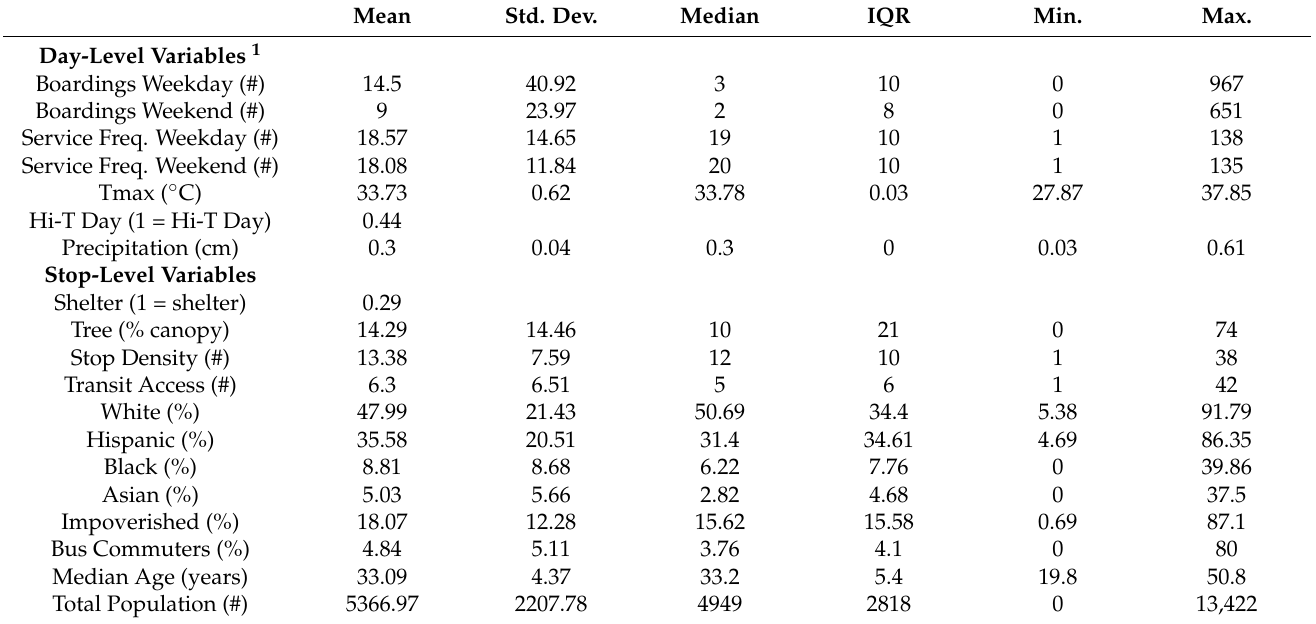
Table 1. Summary statistics of study